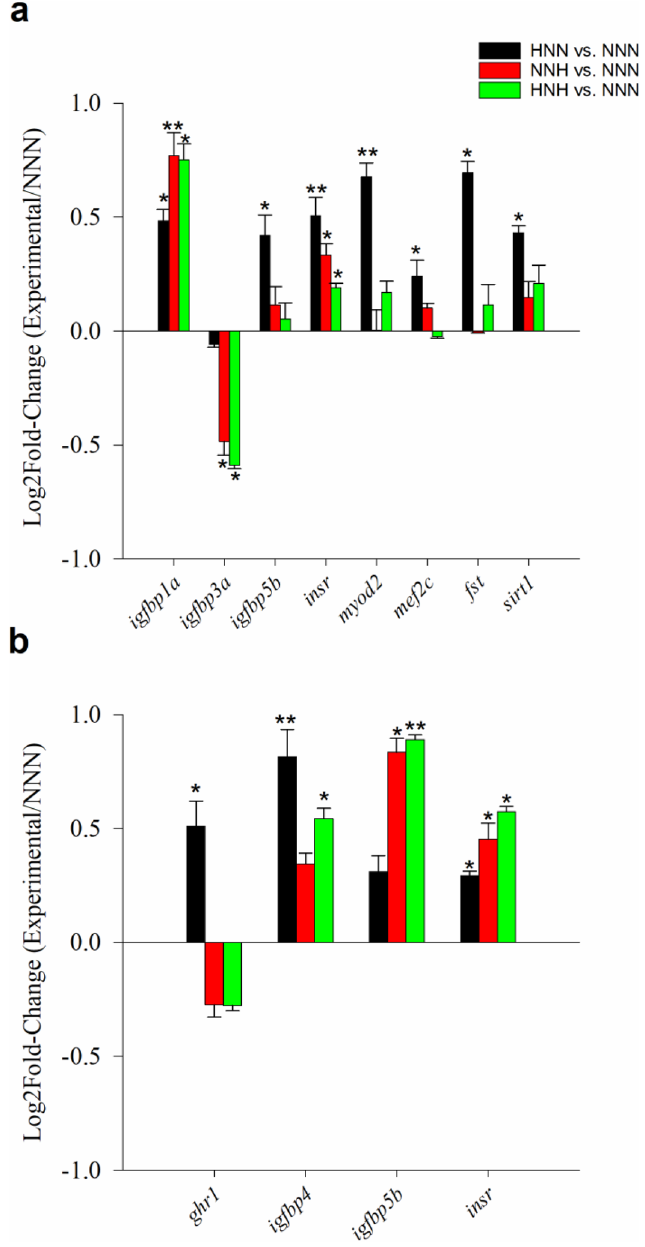
Figure 2. Fold-change (relative to normoxic fish, NNN) of differentially expressed genes in muscle ( a ) and liver ( b ) of gilthead sea bream fingerlings (127 dph) with different history trajectories of O 2 availability: early hypoxic (HNN, black bars), late hypoxic (NNH, red bars), and early and late hypoxic (HNH, green bars). Values are the mean ± SEM of 6 fish. Asterisks indicate statistically significant differences with NNN group ( t test, * P < 0.05; ** P <